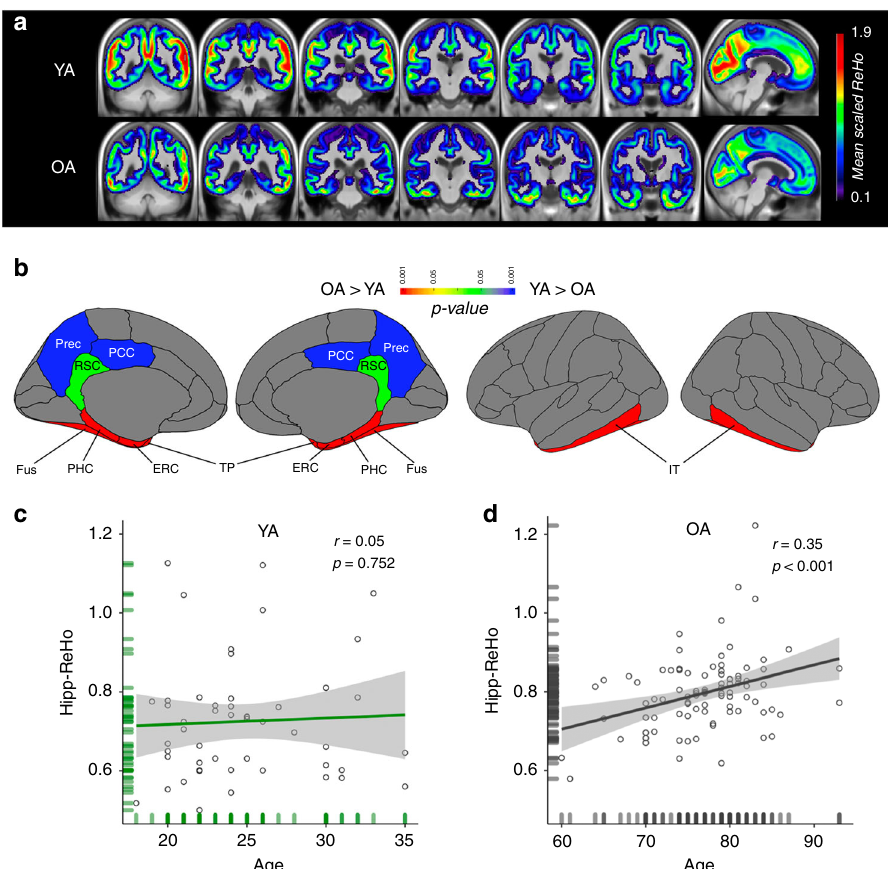
Fig. 2 Patterns of ReHo in gray matter change with age. a Group mean ReHo images of YA ( n = 50) and OA ( n = 89) demonstrated distinct ReHo patterns. Areas of high ReHo in YA were lateral parietotemporal junction, precuneus, and primary visual areas. In OA, high ReHo was observed in a majority of the temporal lobe. b ANOVA was used to compare ReHo in a priori cortical ROIs between YA and OA. Differences in ReHo signal were observed in all illustrated ROIs except RSC where the difference was trending ( p = 0.081). ReHo in AT ROIs, PHC, and ERC was signi fi cantly greater in OA than YA (all p < 0.001), while ReHo in PCC and Prec was signi fi cantly lower in OA than YA (all p < 0.001). c There was no relationship between age and hipp-ReHo in YA ( r = 0.05, p = 0.75; all r and p -value pairs re fl ect Pearson correlation). d In contrast to YA, there was a signi fi cant positive relationship between age and hipp-ReHo in OA ( r = 0.35, p < .001). Source data are provided as a Source Data fi le. YA young adults, OA older adults, Prec precuneus, PCC